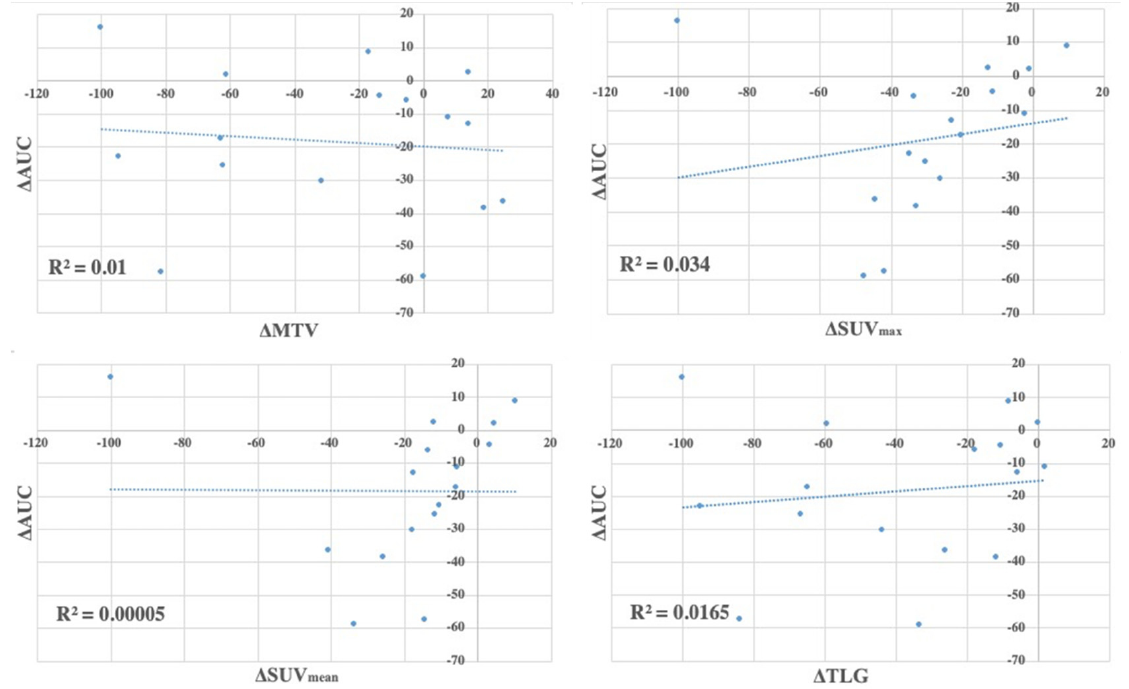
Figure 4. Correlation between Δ AUC and Δ metabolic tumor volume ( Δ MTV), Δ SUV max , Δ SUV mean , and Δ total lesion glycolysis ( Δ TLG).